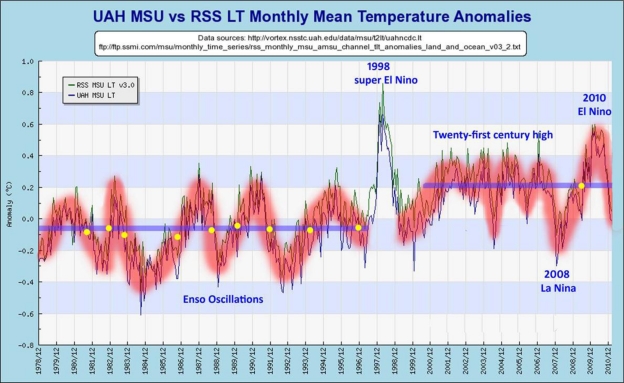
Trend shift in monthly satellite global temperature data. Source: Arrak [50], as updated by him and communicated to the author in March, 2011.